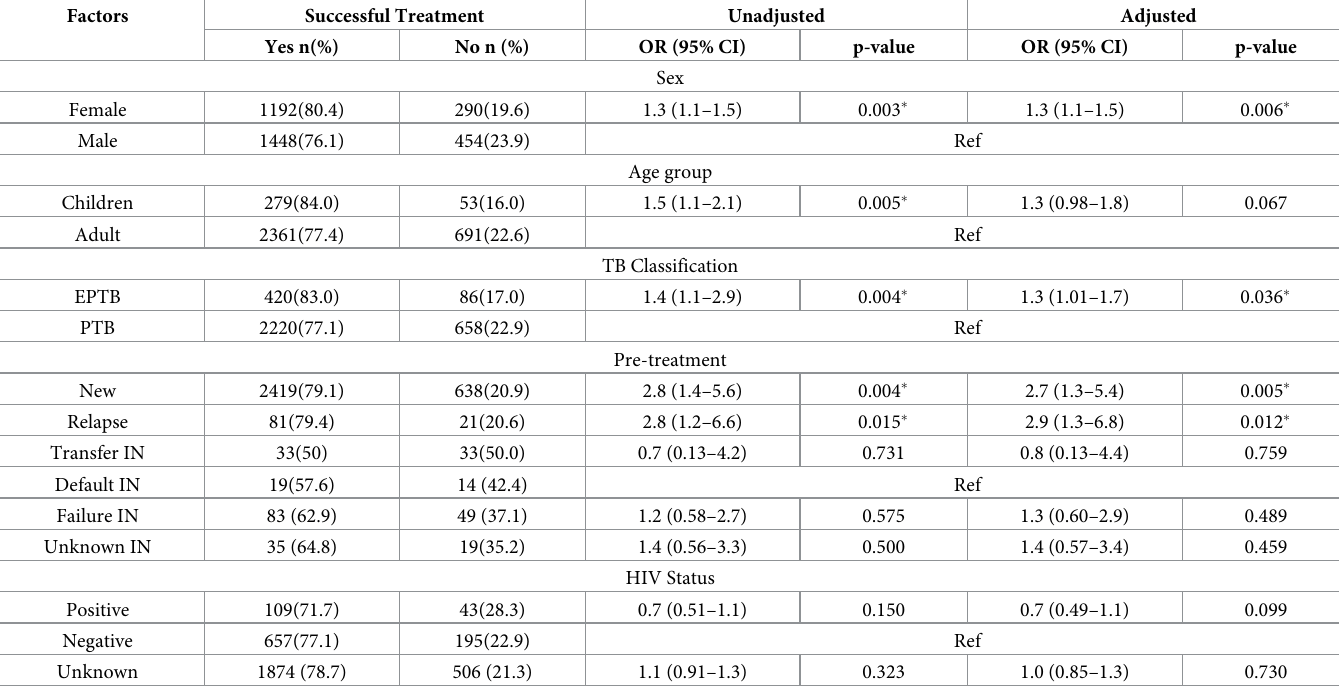
Table 4. Factors associated outcomes: Successful treatment